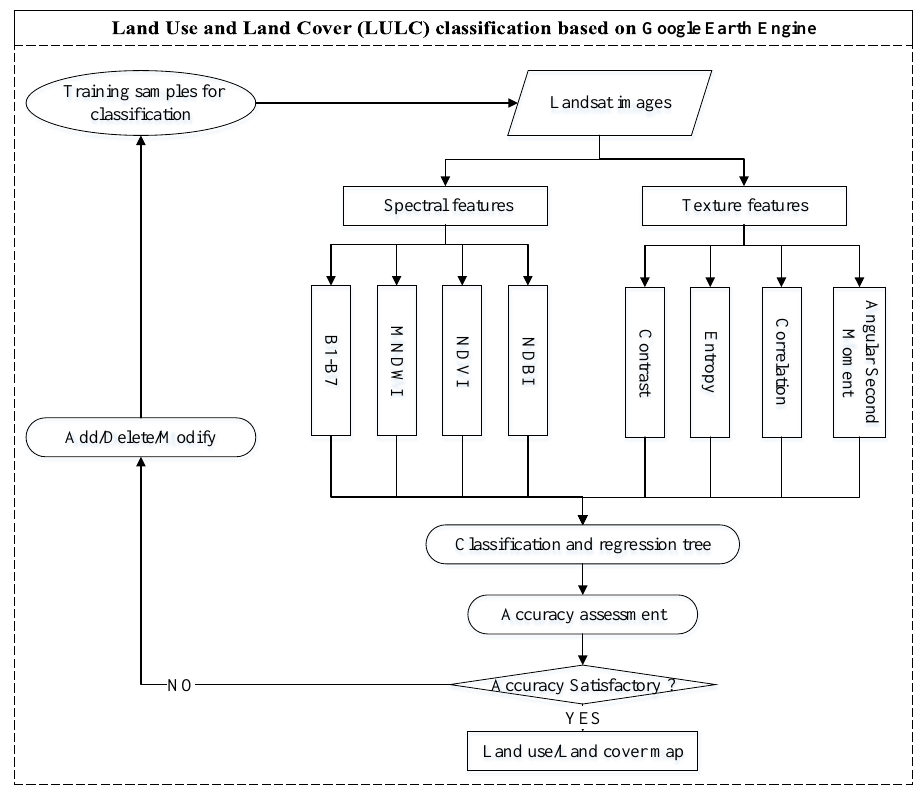
Figure 2. Technical flow chart of LULC data modification.